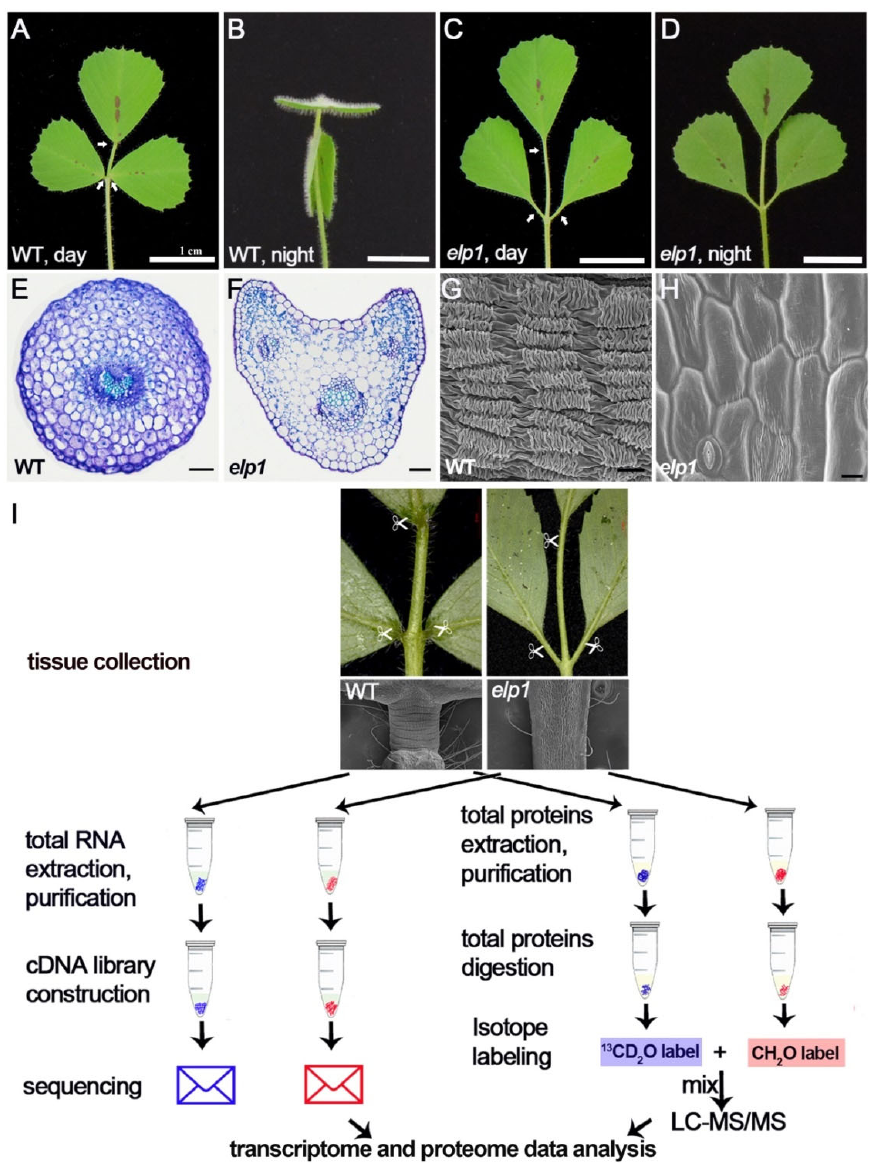
Figure 1. Collection of WT pulvini and the defective pulvinus of elp1 mutant for transcriptome and proteome analyses. ( A , B ) Morphological analysis of 4-week-old seedling of WT. Leaves remain open in horizontal state during the day ( A ) and fold up to vertical position at night ( B ). Bar = 1 cm. ( C , D ) Morphological analyses of 4-week-old seedling of elp1 mutant. Leaves stay open at horizontal level during the day ( C ) and at night ( D ). Bar = 1 cm. Arrows indicate WT pulvini in A and the equivalent positions of elp1 in C. ( E – H ) Histological ( E , F ) and morphological ( G , H ) analyses between WT pulvinus ( E , G ) and elp1 equivalent tissue ( F , H ). Scale bars: ( E , F ) 50 µ m, ( G , H ) 10 µ m. ( I ) Schematic workflow of transcriptome and proteome analysis of elp1 and WT. Collection of WT pulvinus and the defective pulvinus of elp1 from eight-week seedlings for further multidimensional